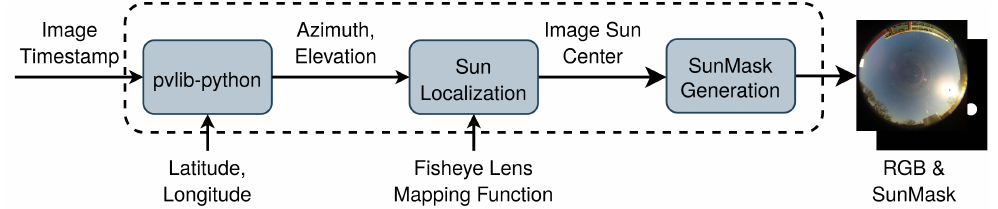
Figure 5. Summary of the steps in the SunMask generation image processing